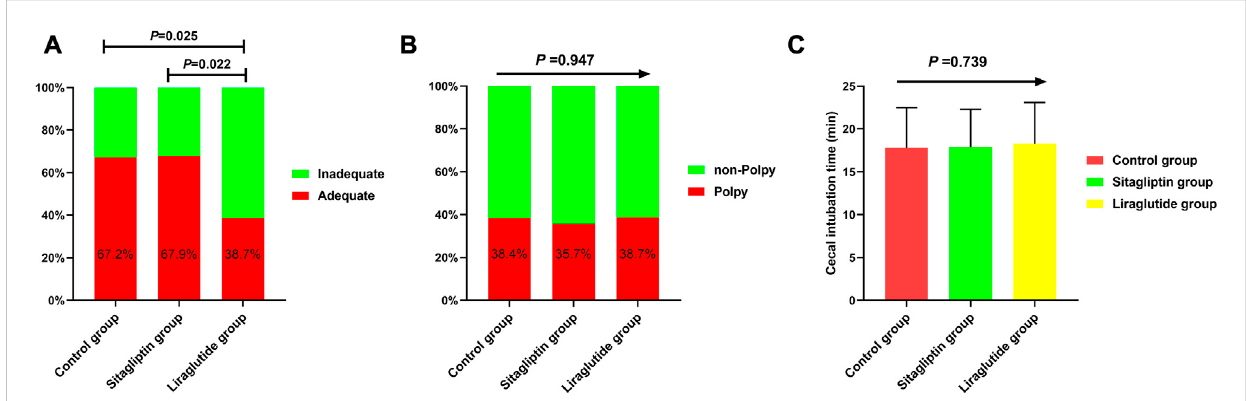
FIGURE 3 Theincidenceofinadequatebowelcleaning (A) ,polyp-detectingrates (B) ,andcecalintubationtime (C)